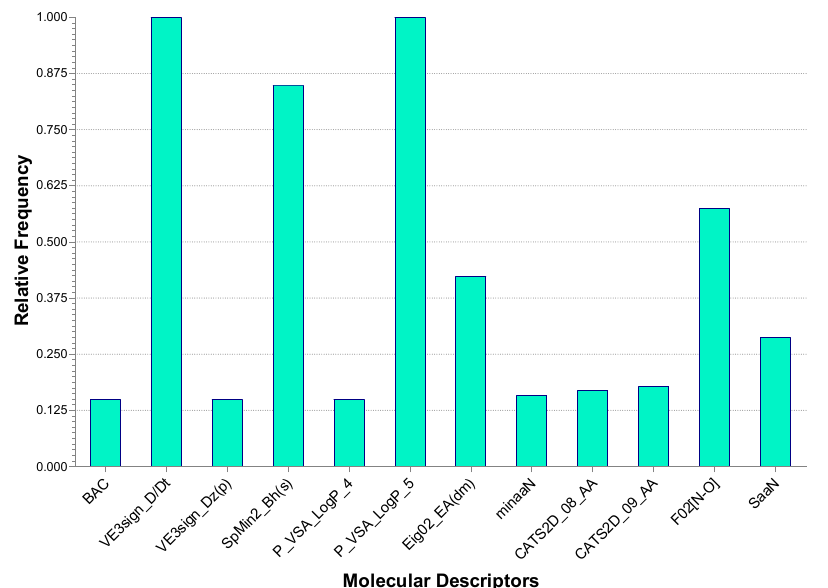
Figure 2. Occurrence of descriptors in the generated 5-descriptor models. BAC: Balaban centric index; VE3sign_Dz(p): logarithmic coefficient sum of the last eigenvector from Barysz matrix weighted by polarizability; P_VSA_logP_4: the sum of Van der Waals surface area of atoms having a logP value in the range from − 0.25 to 0; minaaN: minimum E-state value of aromatic N; CATS2D_08_AA: number of hydrogen bond acceptors at in-between topological distance of 8 bonds; SaaN: sum of E-states of aromatic